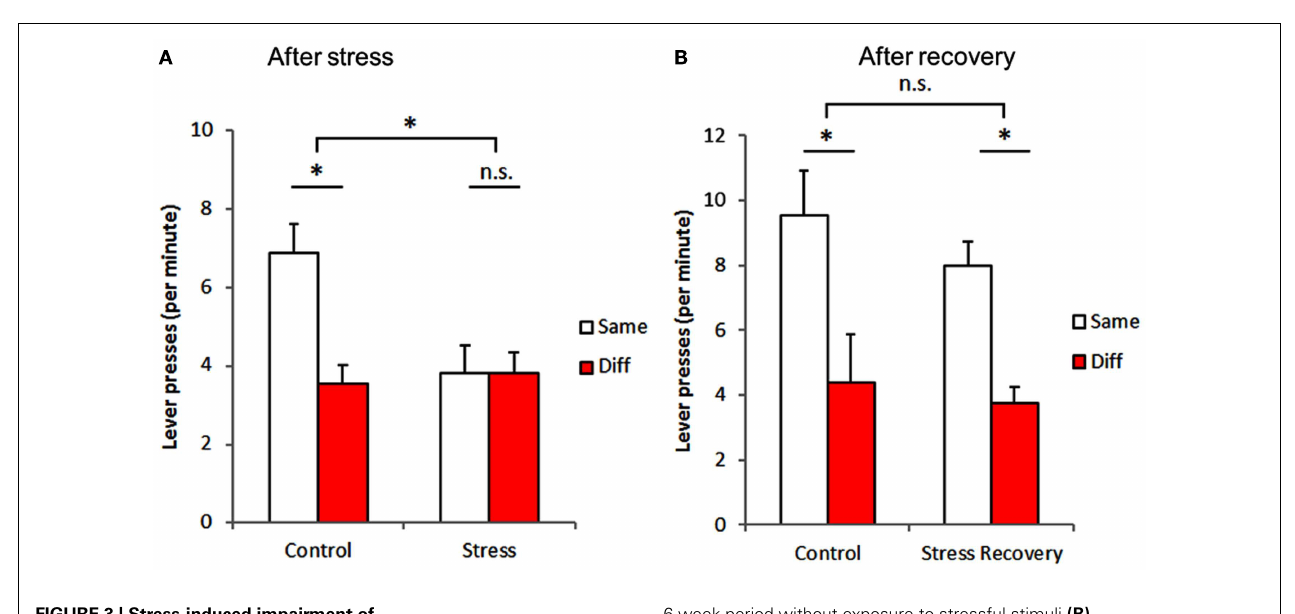
FIGURE 3 | Stress-induced impairment of Pavlovian-to-instrumental transfer is reversible. Stress exposure resulted in an impairment of the association between Pavlovian and instrumental behavior (A) , which was no longer observed after a